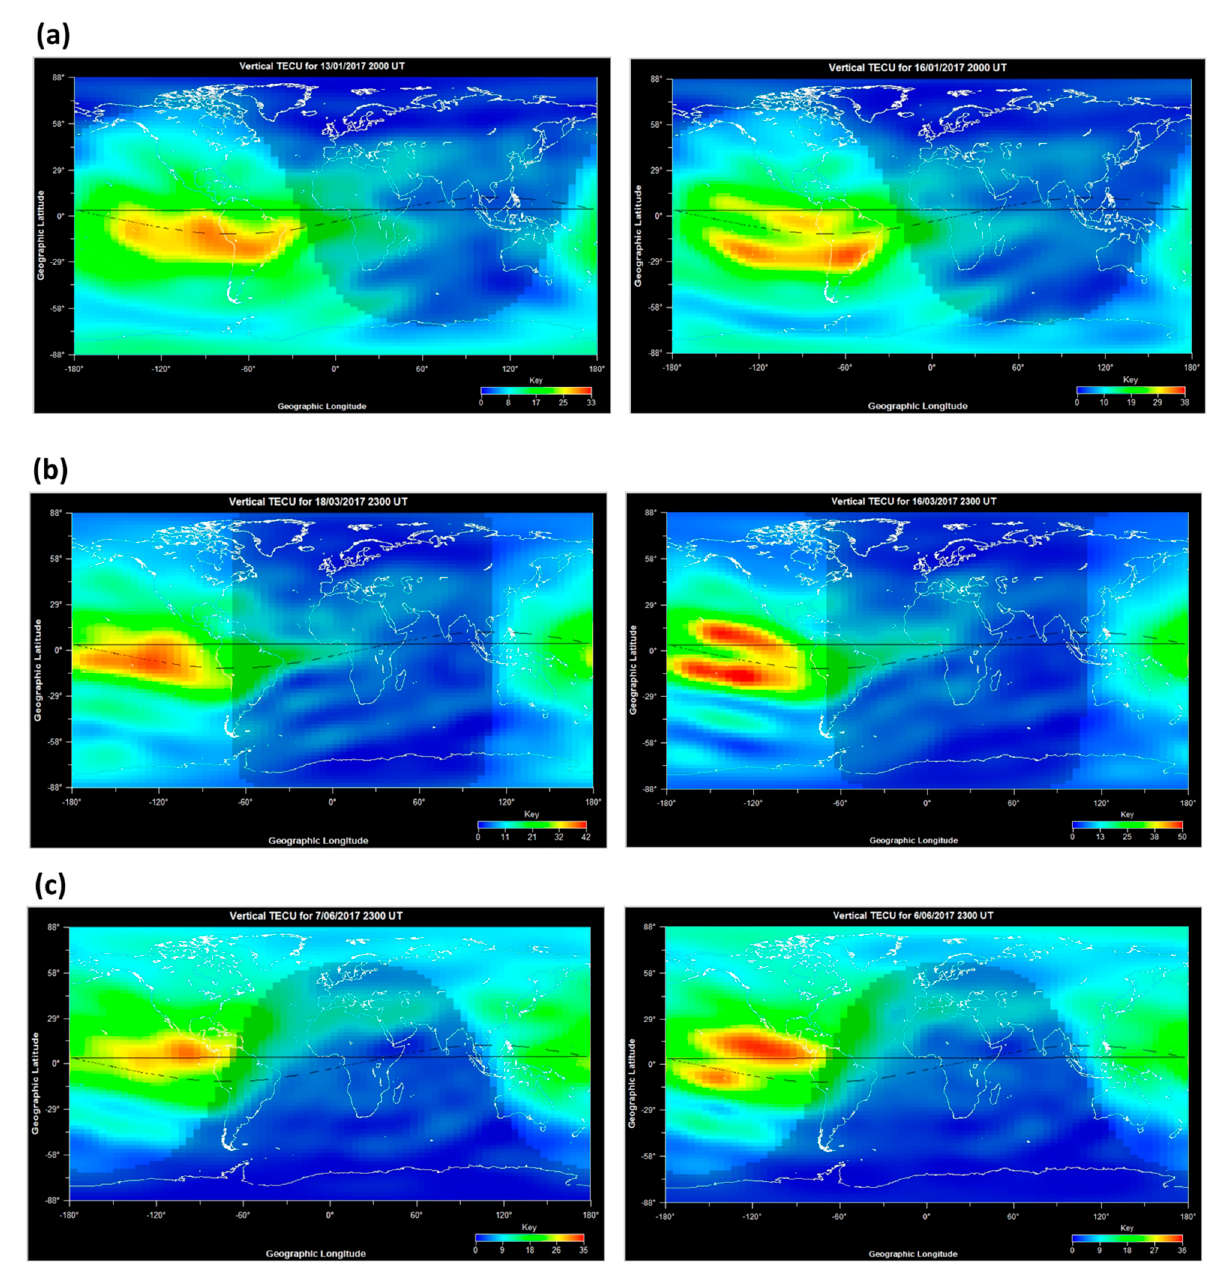
Figure 6. Global TEC maps at: ( a ) 20UT (15LT in earthquake preparation area) during 13 and 16 January 2017 (upper panels), ( b ) 23UT (18LT) on 18 and 16 March 2017 (middle panels) and ( c ) 23UT (18LT) on 7 and 6 June 2017 (lower panels). Units are in TECU. Left panels show the modification of EIA few days prior to the earthquakes and right panels the EIA structure during normal and seismically quiet conditions.